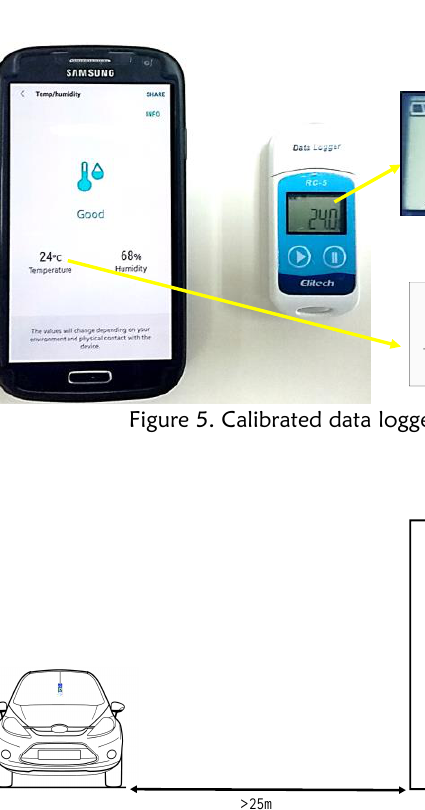
Figure 7. Condition 1, car is fully exposed to sunlight and located more than 25 m from any buildings